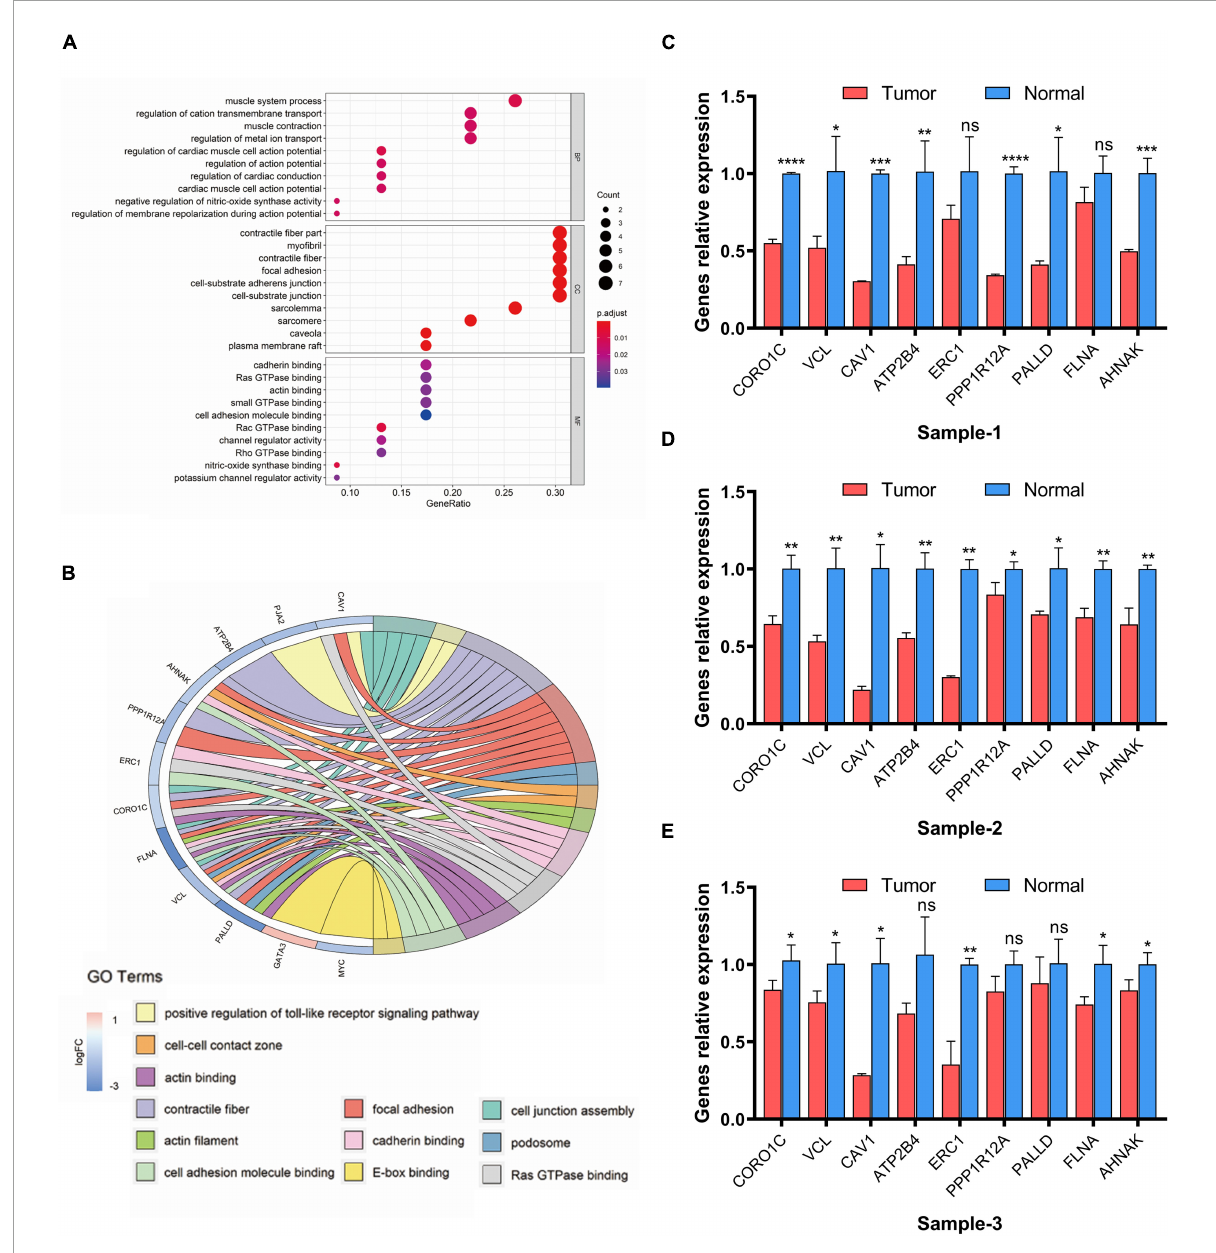
FIGURE6 GO enrichment analysis of eRNAs-related genes. (A) Dot plot of enriched GO terms. (B) Chord plot of enriched GO terms. FDR < 0.05 was considered as statistically significant. (C–E) Real-time PCR analysis of related genes. Data are shown as the mean ± SEM. symbol *, **, ***, ns mean P -value < 0.05, 0.01, 0.001, and no significance